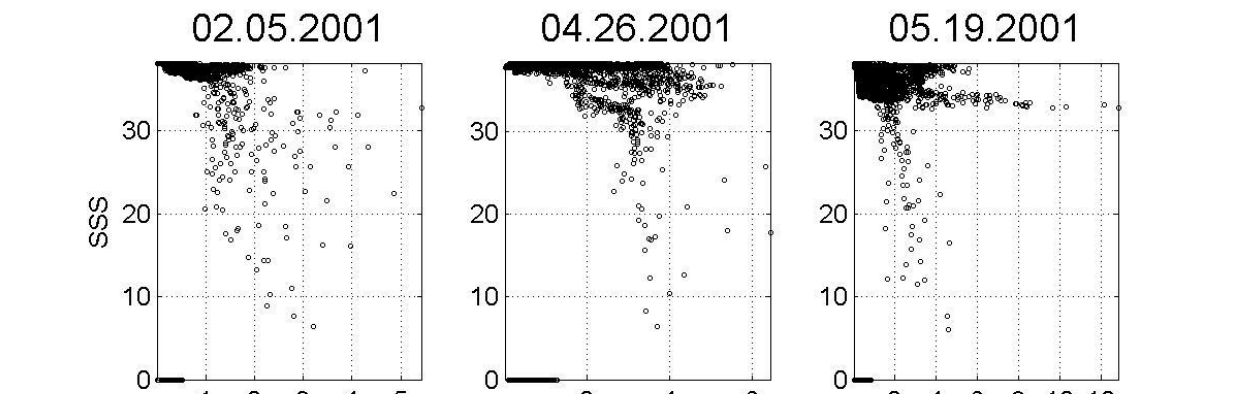
Figure 5. Comparison of MARS surface salinity and SeaWiFS chlorophyll at specific dates for the entire